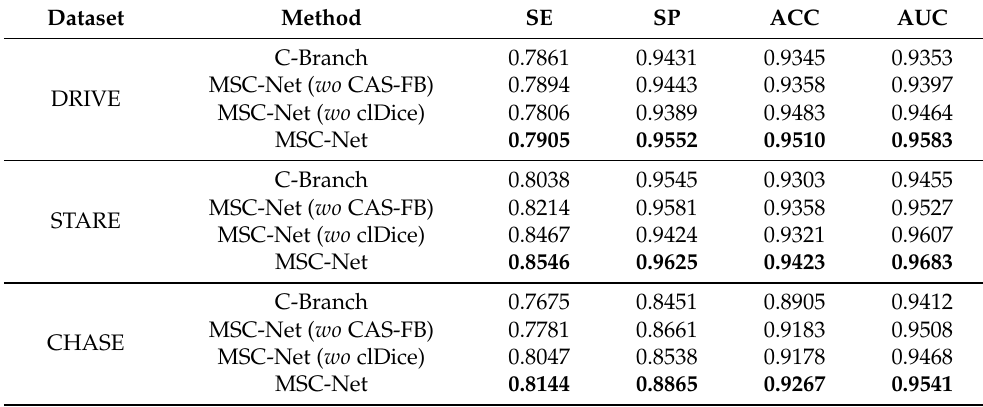
Table 6. Ablation experiments of the effects of different modules on centerline